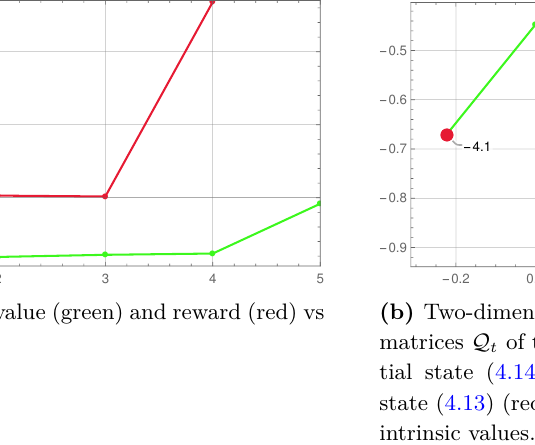
(a) Intrinsic value (green) and reward (red) vs episode steps. Figure 5. Characteristics of the episode connecting the states (4.14) and